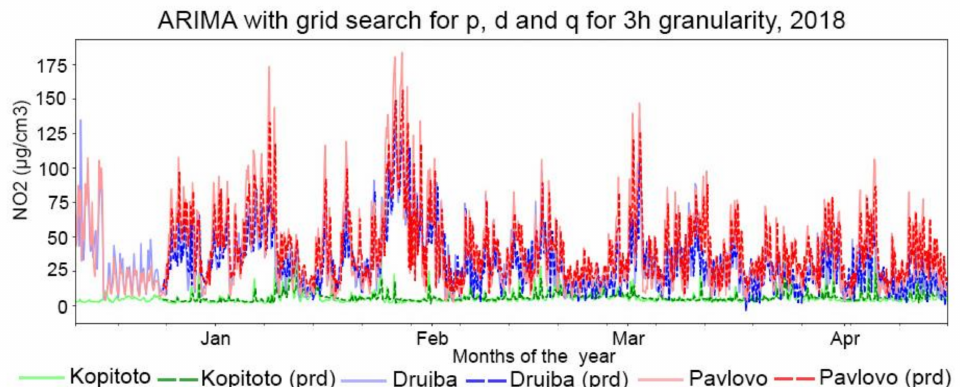
Figure 13. ARIMA model with predictions for NO 2 , 1 h granularity, based on grid search and ACF, PACF lags consideration.